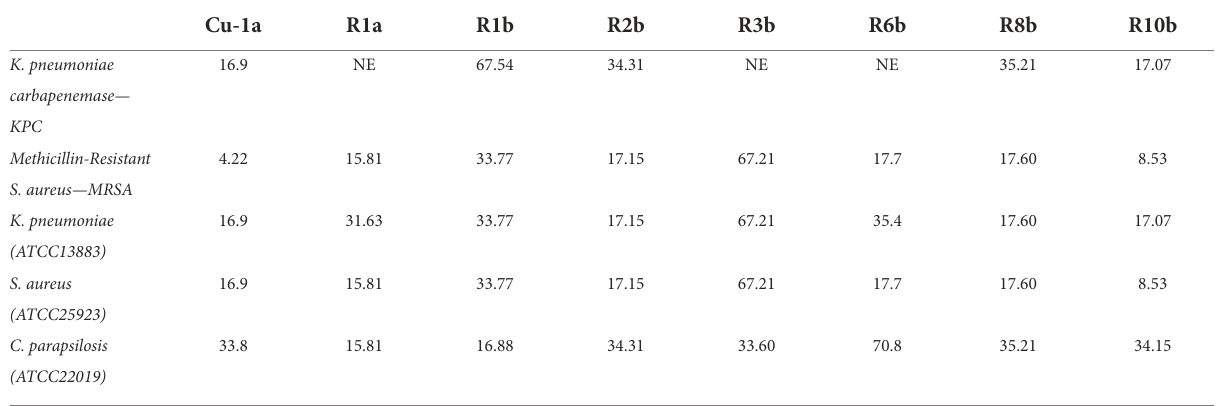
TABLE 3 MIC values found for peptide Cu 1a and their analogs against bacteria and fungi. Bacterial